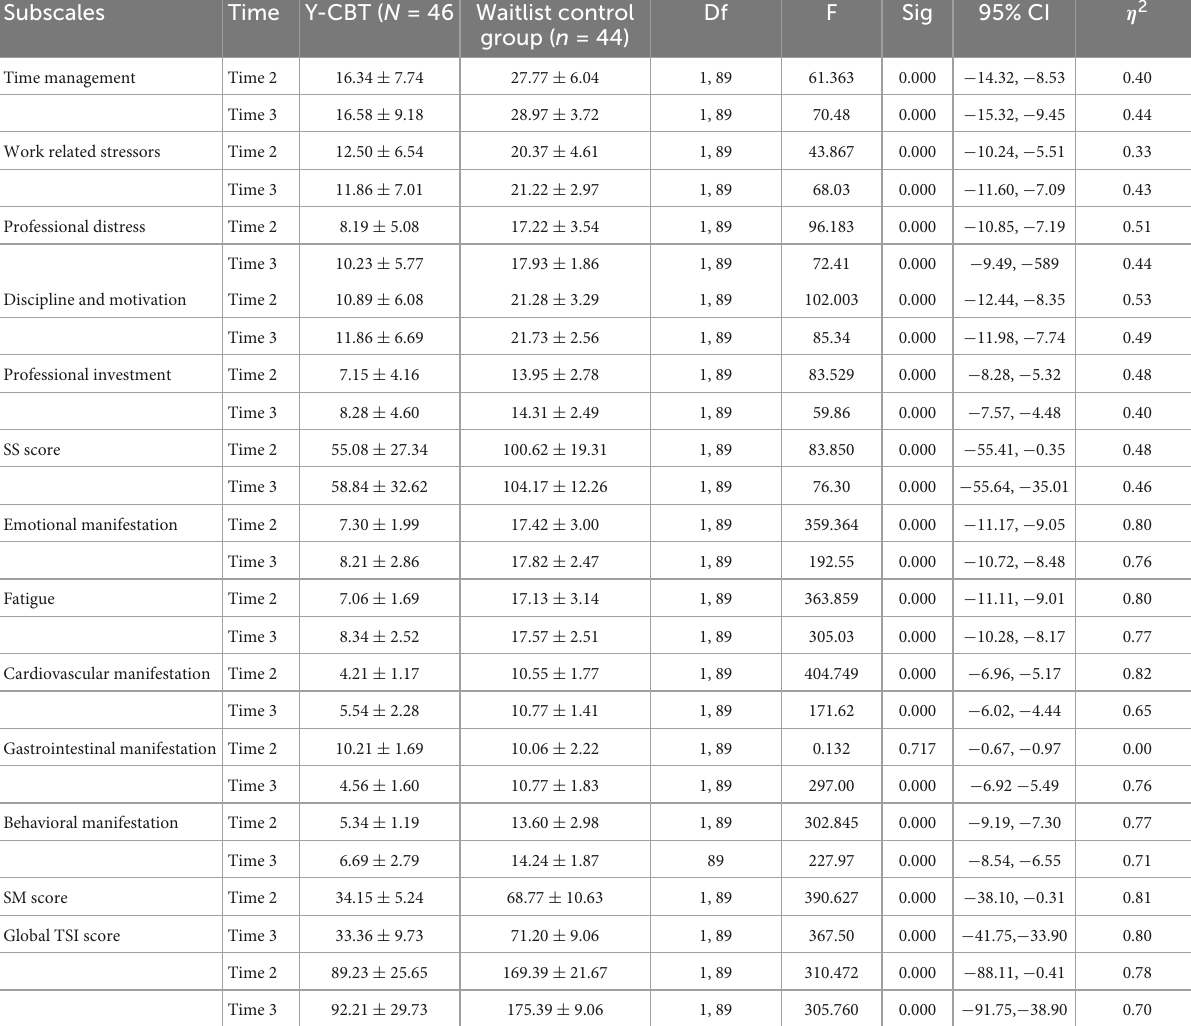
TABLE 3 Repeated measures ANOVA for post-test and Follow-up evaluation.